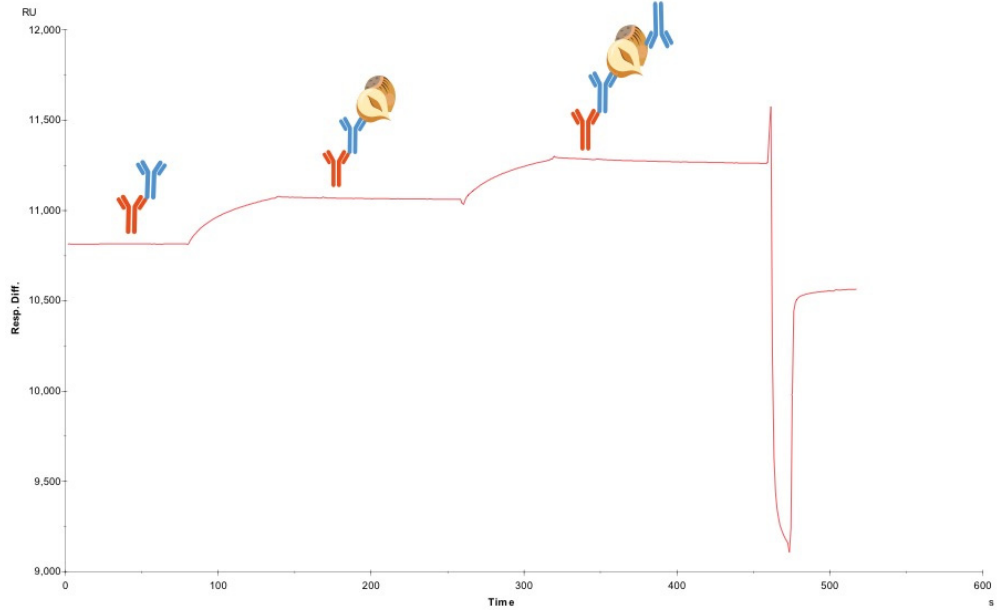
Figure 2. SPR based sandwich pairing. Sensorgram depicting crude “good” sandwich pair